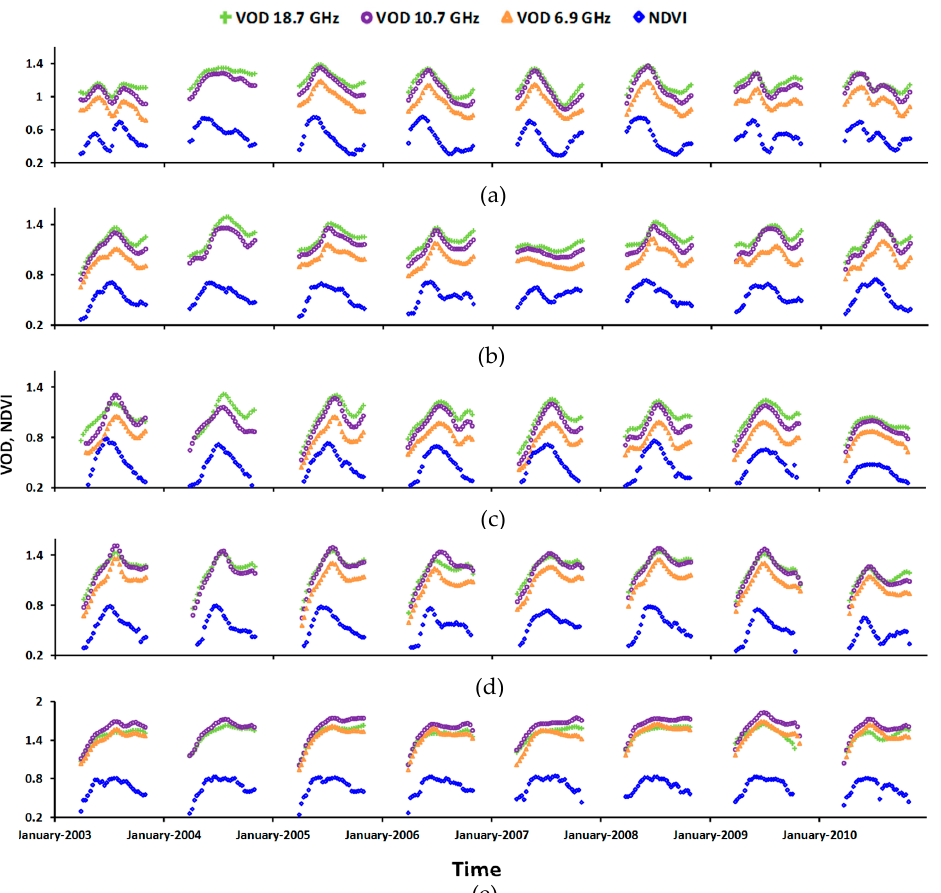
Figure 4. VOD time series for the three microwave frequencies: green pluses = 18.7; purple circles = 10.65; orange triangles = 6.925 GHz; and blue diamonds = NDVI. Selected series arranged from south to north of our study region: ( a ) Stavropol, RU, site 2; ( b ) Kirovohrad, UA, site 15; ( c ) Petropavlovsk 3, KZ, site 42; and ( d ) Kazan, RU, site 49; and ( e ) Mari El, RU, site 50 (MFO site included for contrast). Note that the VOD range for the MFO site is higher (0.2–1.9) than the range for the cropland sites